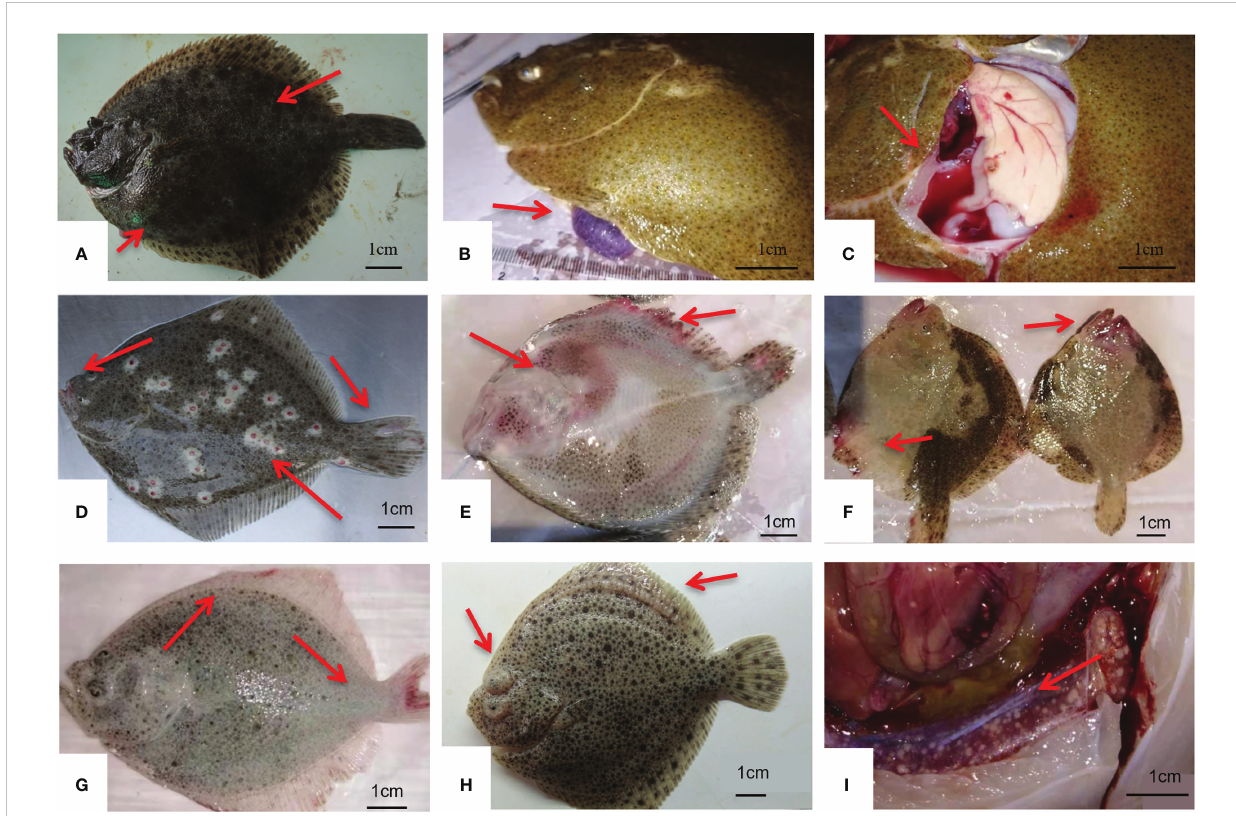
FIGURE 6 Symptoms of diseased fi sh. (A, B, C) show turbot infected with Aeromonas salmonicida , with symptoms of cutaneous nodules ( (A) ; Wang et al., 2020), hemorrhage in the abdomen and rotten fi ns (B) , hemorrhage in the mouth (C) ; (D, E, F) show turbot infected with Edwardsiella piscicida with symptoms of ascites (D) , rectal prolapse (E) , and pale livers (F) ; (G) shows turbot infected with Vibrio anguillarum with rotten tail and fi ns; (H) shows turbot infected with Mycobacterium marinum with renal granulomas (Li et al., 2019). (I) shows turbot infected with Streptococcus parauberis with bilateral exophthalmus and pus in the eyes and pus in fi ns (Gao et al., 2021). The red arrows mean typical